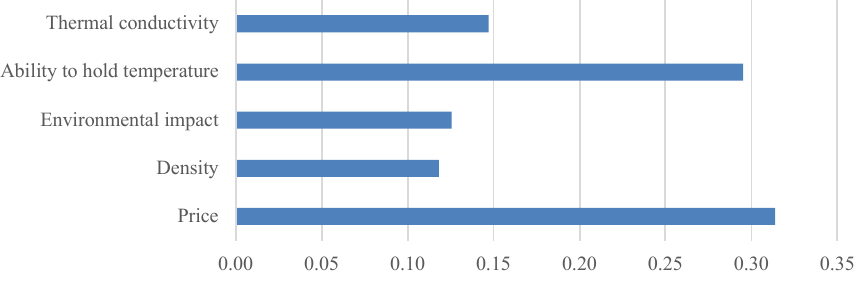
Fig. 2. Chosen quantitative criteria and their weights showing the importance of each criterion in the final decision making. As shown above, after narrowing down to five criteria, price, and ability to hold temperature